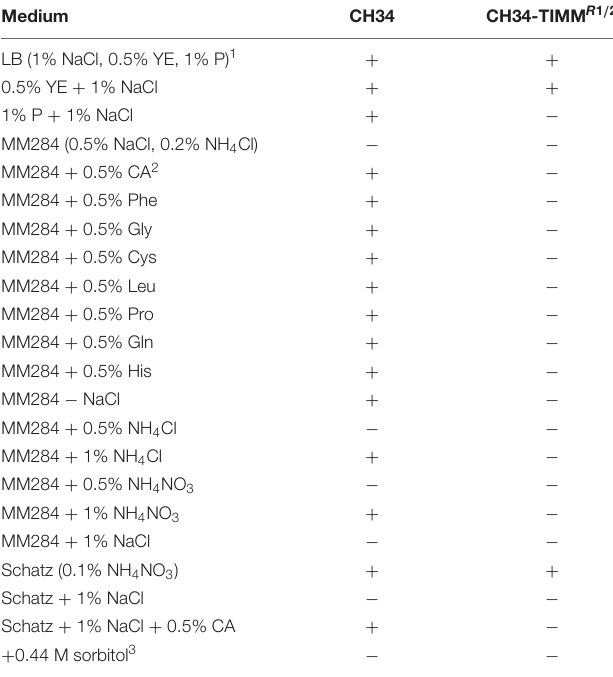
TABLE 3 | Different media and strains used in this study to evaluate TIMM induction ( + for induction and − for no induction) as determined by the ratio of viable count at 37 to 30 ◦ C.